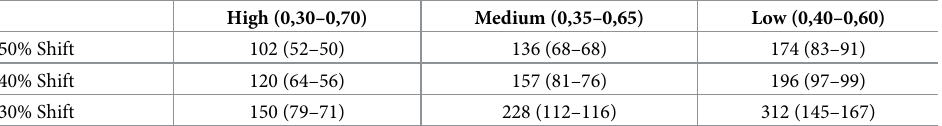
Table 2. Frequencies per strategy switch (shift to exploratory-exploitative innovation strategy in focal acquisition).